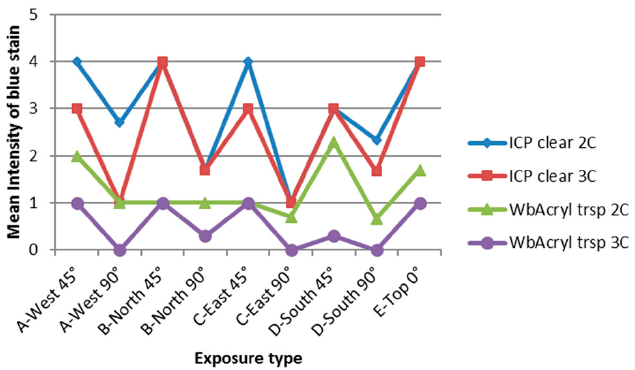
Figure 7. Mean area of blue stain after six months of exposure (February 2016) using the MFER.